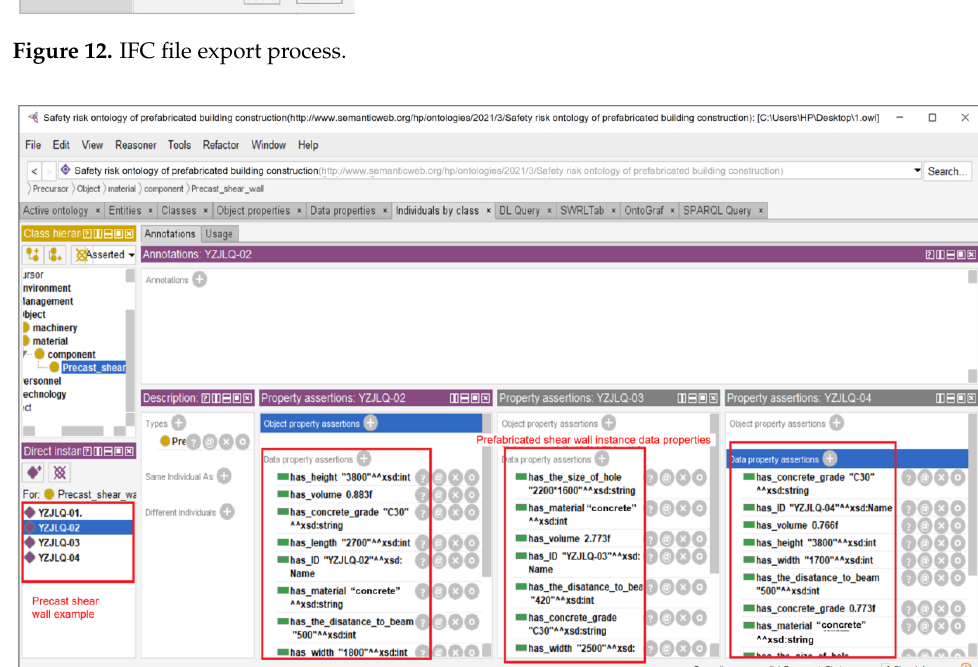
Figure 13. Ontology instance